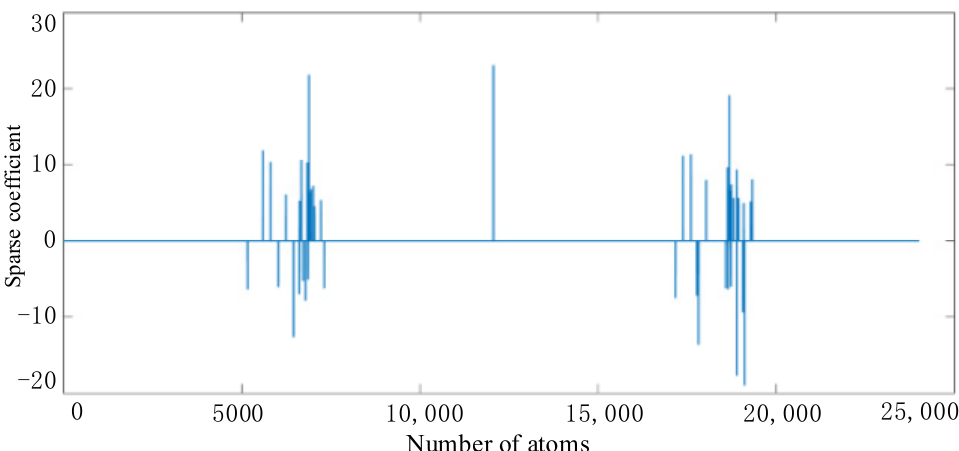
Figure 17. Sparse representation coefficients.